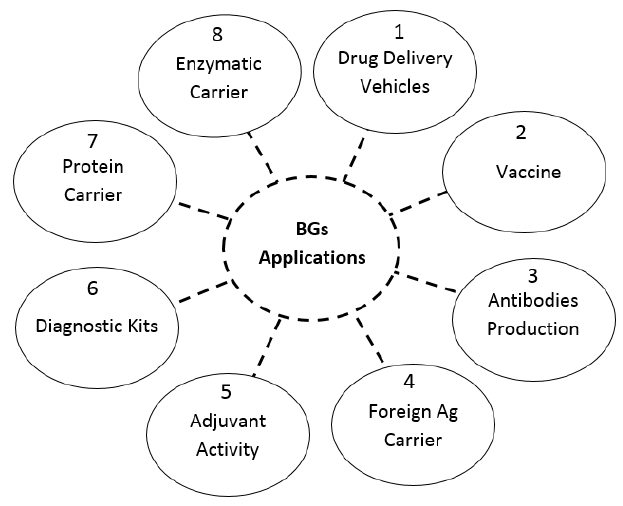
Figure 3. The most important clinical applications of BGs.